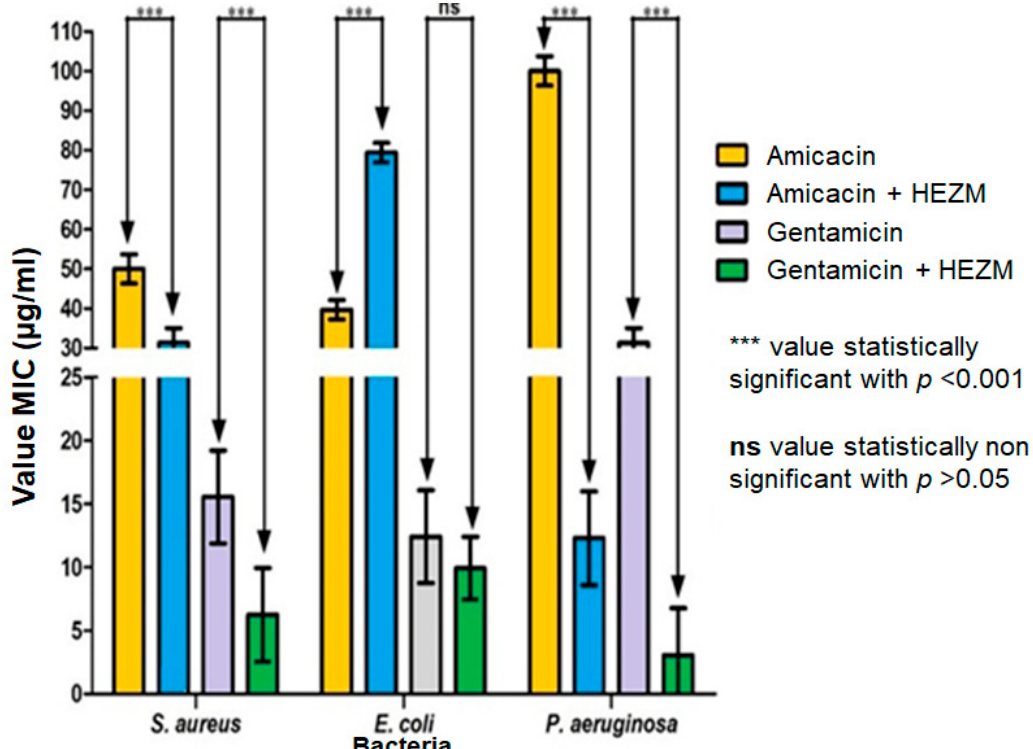
Figure 1. Antibiotic-modulating effect of HEZM against multiresistant bacteria.